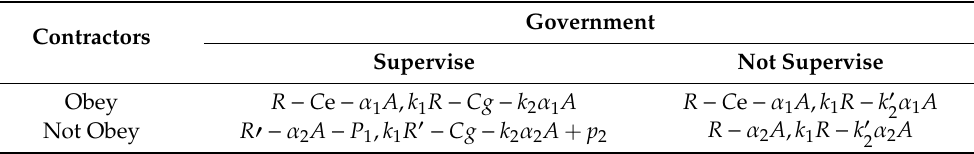
Table 2. Payo ff matrix between government and